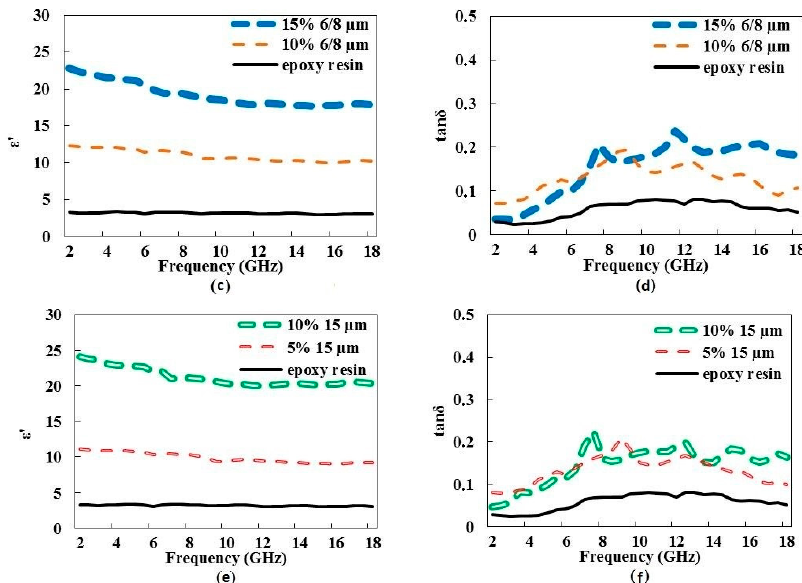
Figure 3. Variation of dielectric constant ε ’ and loss tangent tan δ vs. frequency of epoxy resin loaded with a 3-µm graphene particle size ( a , b ); a 6–8-µm graphene particle size ( c , d ); and a 15-µm graphene particle size ( e , f ) with various weight ratios, respectively. Pristine epoxy resin values are given for reference.